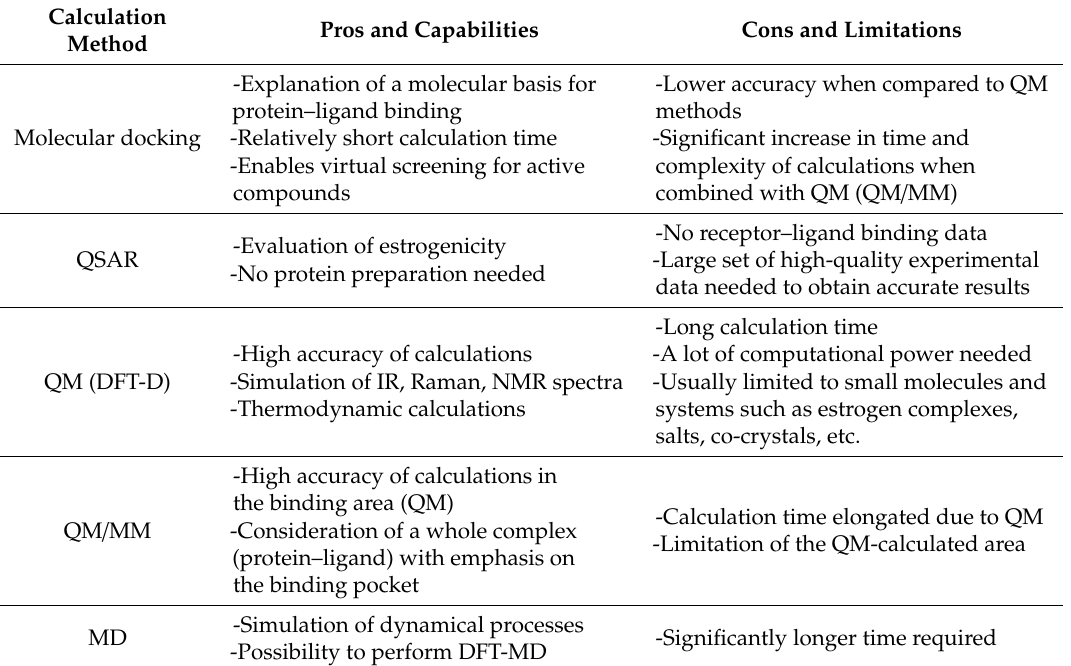
Table 4. Comparison of the calculation methods used in (xeno)estrogen